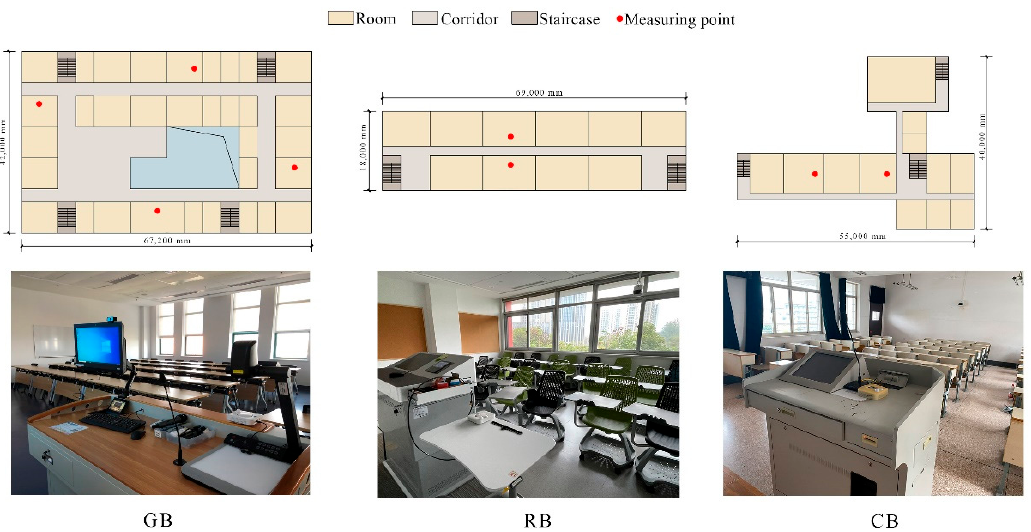
Figure 1. Typical layout of selected buildings and photos of measuring points.